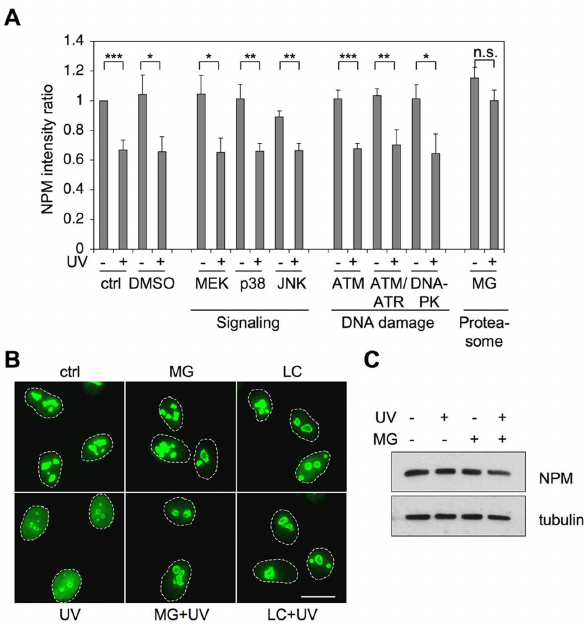
Figure 2. UV-activated NPM relocalization is prevented by treatment with proteasome inhibitor. A U2OS cells were treated with inhibitors targeting UV-activated cellular signaling (U0126 10 m M for MEK, SB203580 20 m M for p38 and SP600125 100 m M for JNK), DNA damage signaling (KU55933 10 m M for ATM, wortmannin 100 m M for ATM/ATR and NU7441 10 m M for DNA-PK) and proteasome (MG132 10 m M) or left untreated. One hour later the cells were exposed to UV radiation (35 J/m 2 ) or left untreated. Cells were fixed after 3 hours and stained for NPM and UBF. Cells were imaged and intensities were quantified with Fiji-software using UBF as a nucleolar marker. The ratio of nucleolar and nucleoplasmic intensities was calculated from three independent experiments with two fields imaged per experiment. P - values were calculated using Student’s T test, * P , 0.05; ** P , 0.01; *** P , 0.001. Error bars, SD. N $ 140 cells/analysis. B WS1 cells were treated with proteasome inhibitors MG132 (10 m M) or lactacystin (LC, 10 m M) for 1 hour prior to UV radiation (35 J/m 2 ) or left untreated. The cells were fixed 6 hours later and stained for NPM. Scale bar 20 m m. C WS1 cells were treated with MG132 or left untreated. After 1 hour the